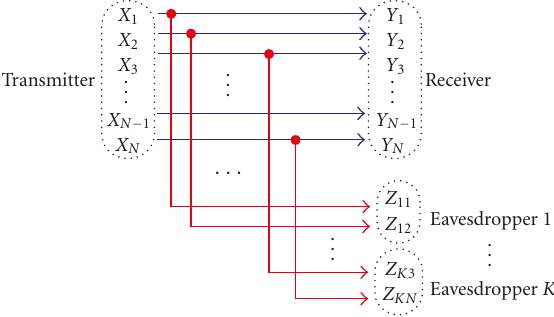
Figure 2: Semideterministic compound wiretap channel.